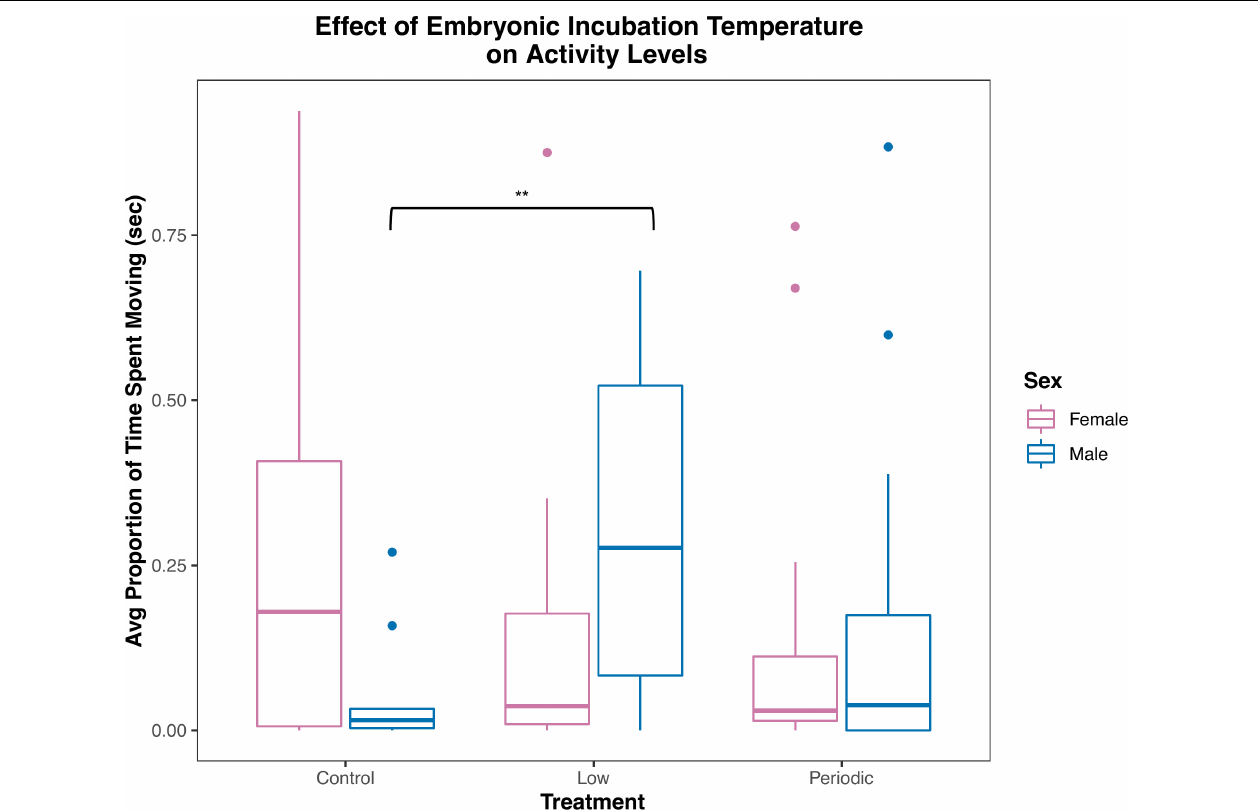
FIGURE 6 | Males in the Low incubation treatment had higher activity levels than those in the Control treatment. The average proportion of time (seconds) spent moving during the handling bag test is recorded on the y-axis. The three incubation treatment groups are shown on the x-axis (Control, Low, and Periodic). Females are indicated by pink boxplots, and males are indicated by blue boxplots. Two asterisks (**) indicate P ≤